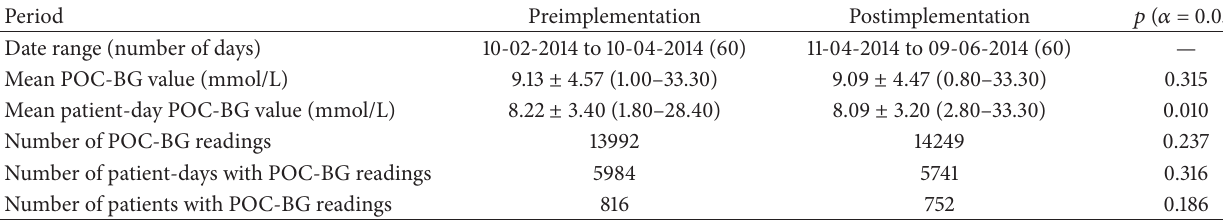
Table 1: Summary statistics for pre- and postimplementation